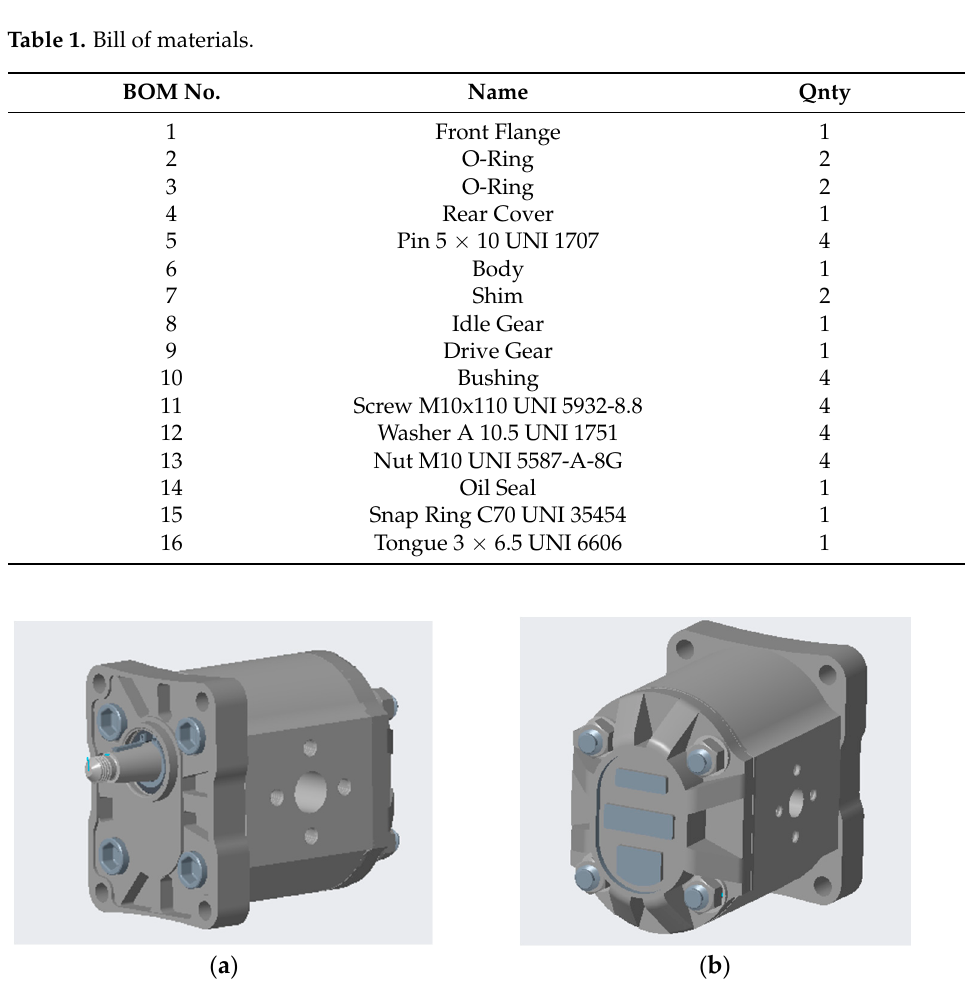
Figure 4. ( a ) Assembly front view; ( b ) Assembly back view.